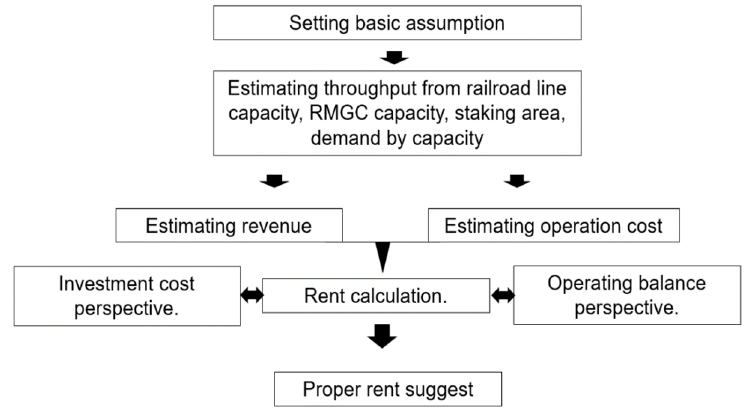
Figure 1. Research